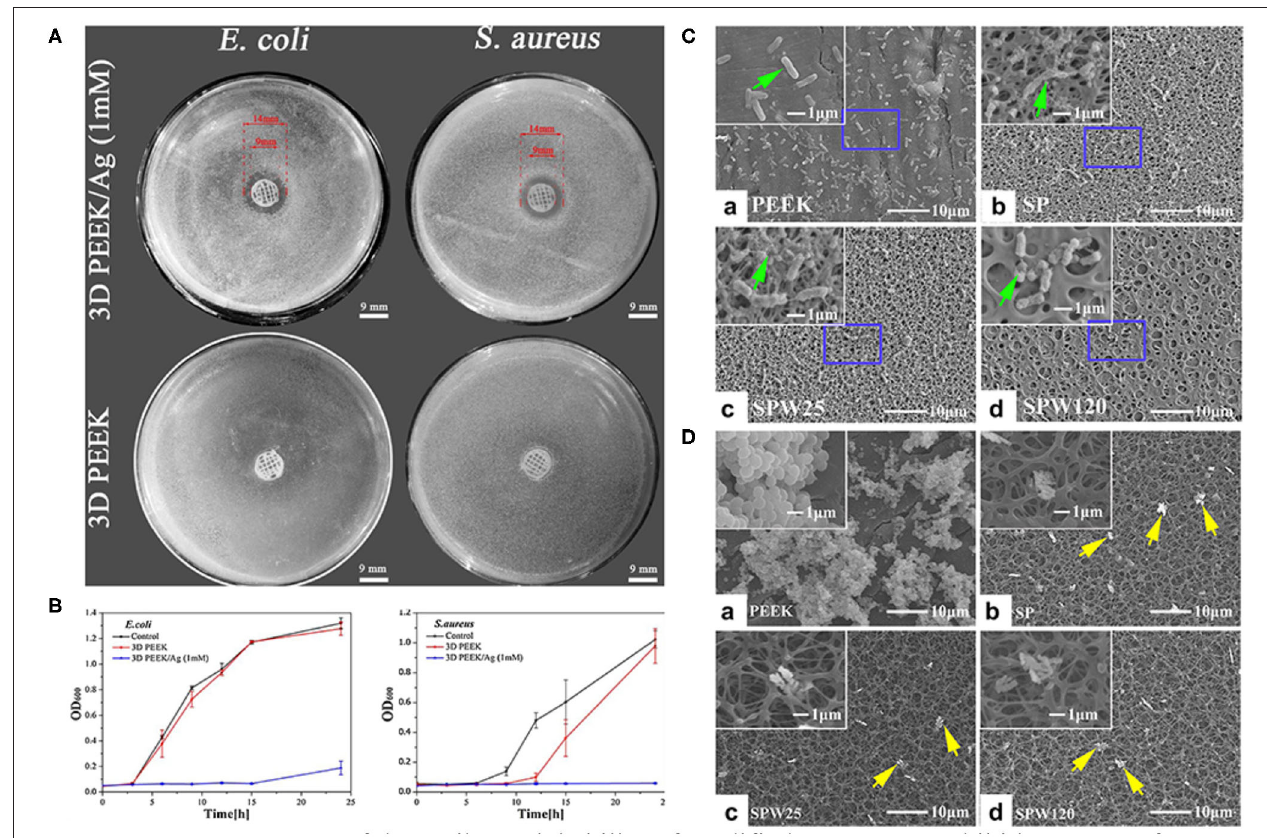
FIGURE 5 | Assessment of the antibacterial ability of modified PEEK. (A) Inhibition zones of 3D PEEK and 3D PEEK/Ag against E. coli and S. aureus . (B) Bacterial dynamic curves of E. coli and S. aureus on 3D PEEK and 3D PEEK/Ag at OD600. Reproduced from Deng et al. (2017). Copyright (2017), with permission from Elsevier. (C) E. coli and (D) S. aureus seeded on the PEEK, SP (sulfonated only), SPW25 (sulfonated and hydrothermal treated at 25 ◦ C), and SPW120 (sulfonated and hydrothermal treated at 120 ◦ C) at a bacteria concentration of 10 7 cfu/ml. The green arrows indicate the morphology of E. coli (high magnification), while the yellow arrows show the morphology of S. aureus (low magnification). Reproduced from Ouyang et al. (2016). Copyright (2016), with permission from Elsevier.